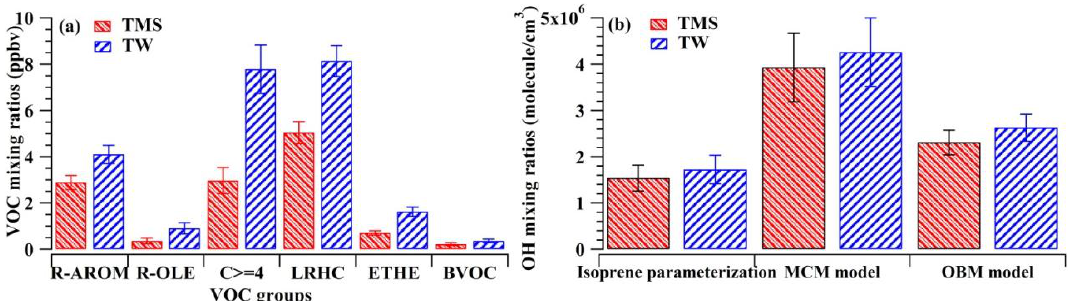
Fig. 3. The mean mixing ratios of (a) different VOC species and (b) OH radical at TMS and TW during the sampling period. Vertical bars are 95% confidence intervals.